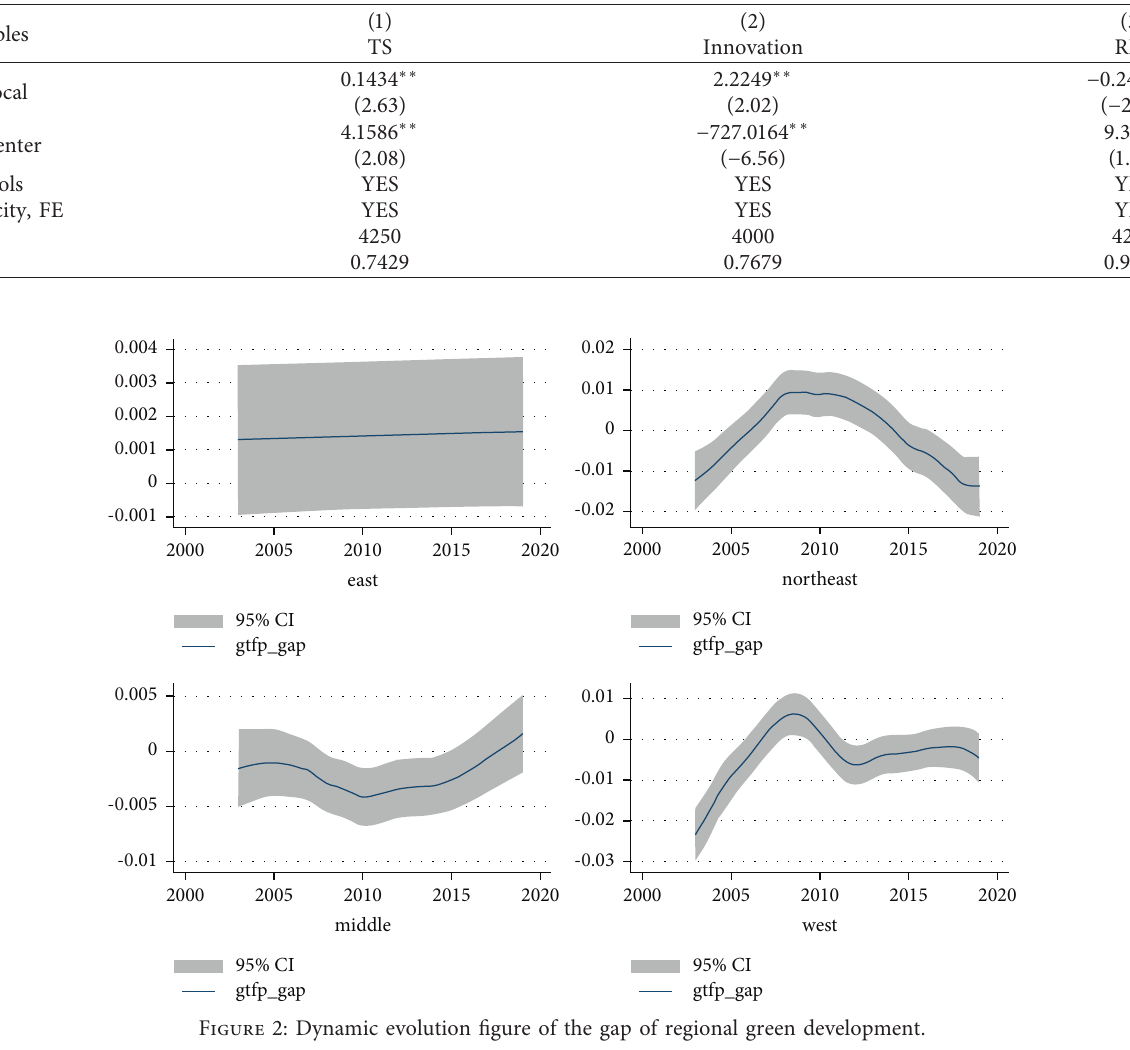
Table 6: Transmission mechanism.